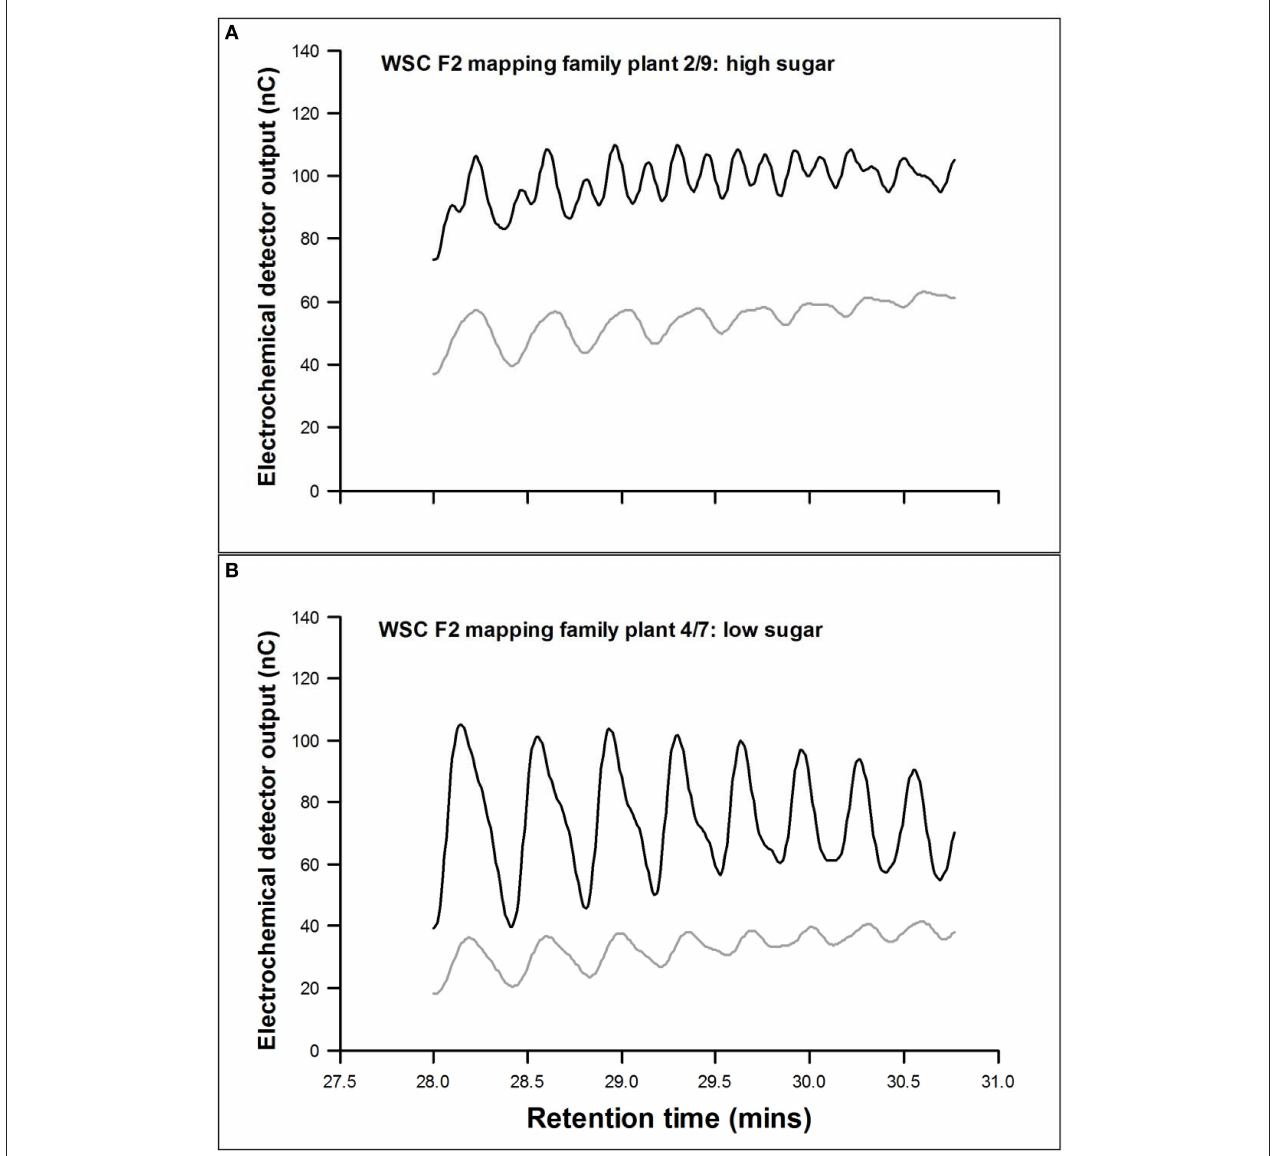
FIGURE 1 | Pattern of fructan polymers between DP28 and DP36 in two contrasting plants. (A) WSC F2 2/9, a high sugar plant and (B) WSC F2 4/7, a low sugar plant. Black line, de novo fructan synthesis during induction; gray line, fructan present in July when fructan content is